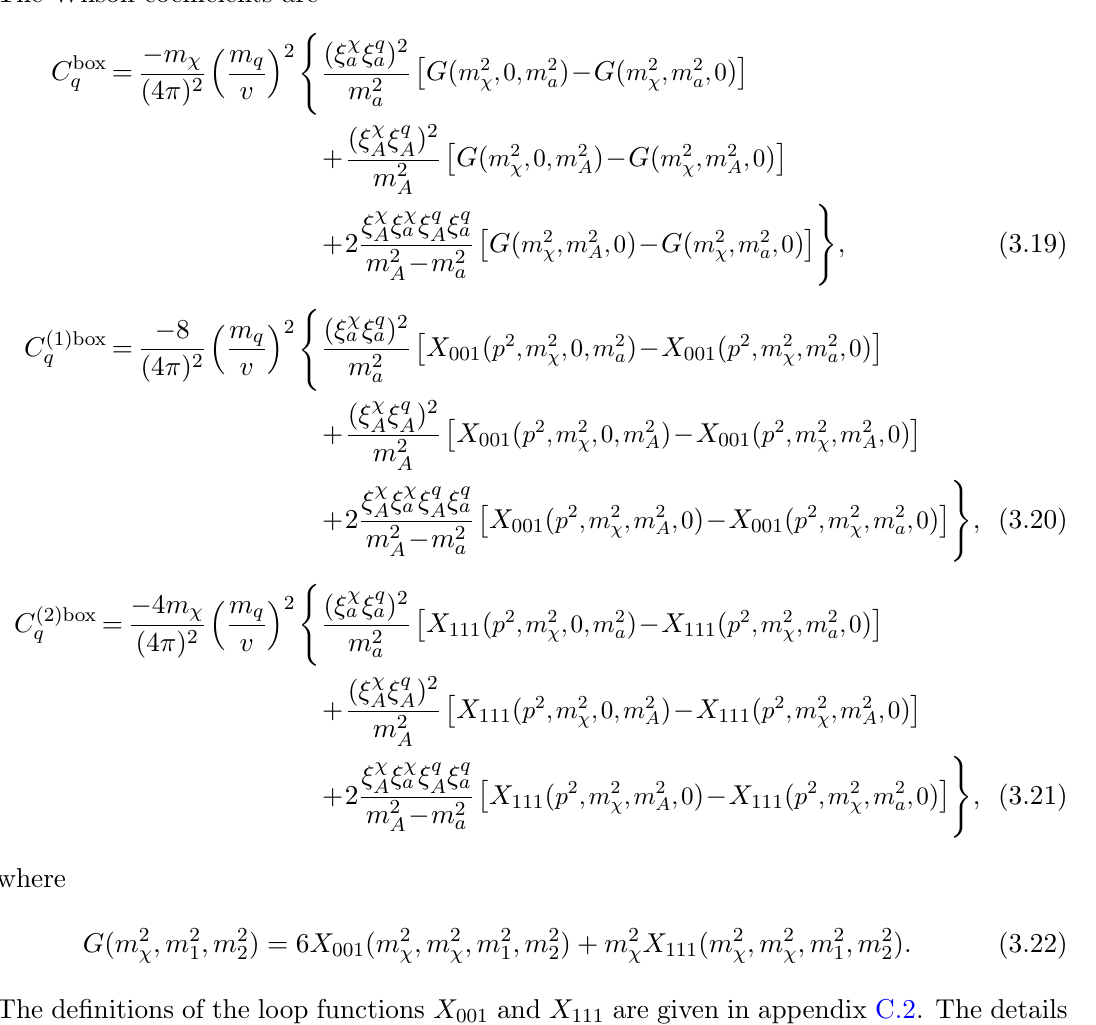
Figure 2 . The box diagrams which induce the DM-quark e(cid:11)ective operators, where a The Wilson coe(cid:14)cients